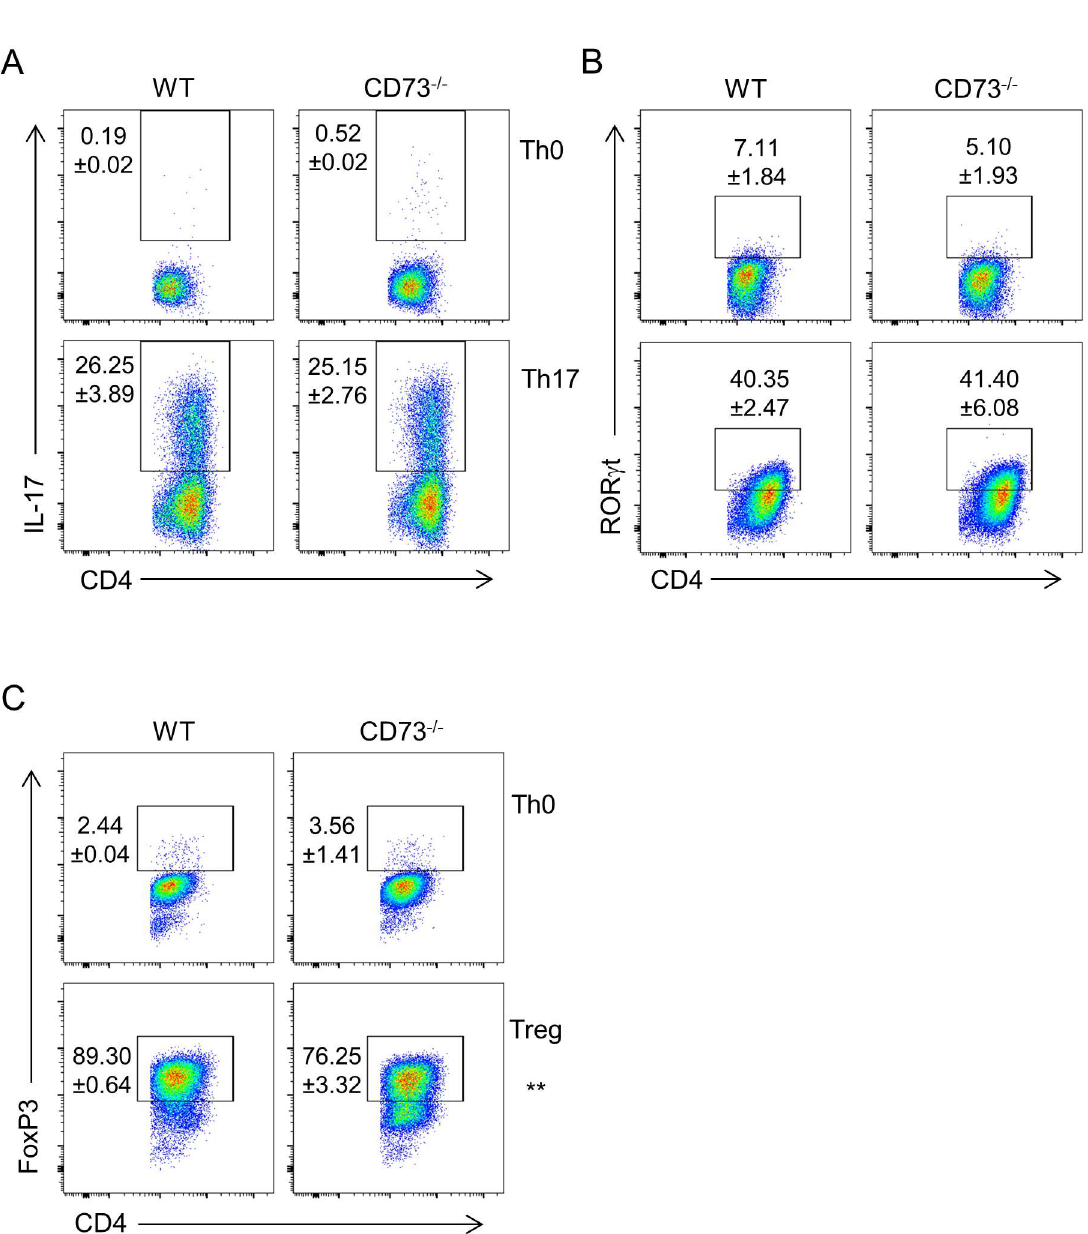
Fig 3. CD73 does not influence Th17 differentiation in vitro . A, B: CD4 + T cells from WT or CD73 -/- mice were cultured under Th0 (top panels) or Th17 (lower panels) differentiating conditions for three days, then expressionof IL-17 (A) and ROR γ t (B) were analyzed.C. Expression of FoxP3 in WT and CD73 -/- Th0 (top panel)and Tregs (lower panel)at day 3 of differentiation. Numbers indicatemean % +/- S.D. of gated cells (n = 2), representative of three independent experiments with similar